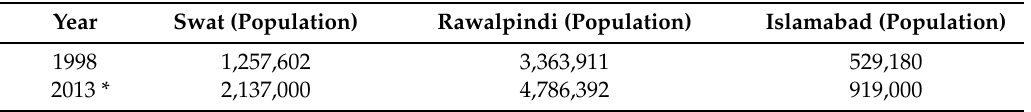
Table 1. Population profile of the Rawalpindi-Islamabad and Swat